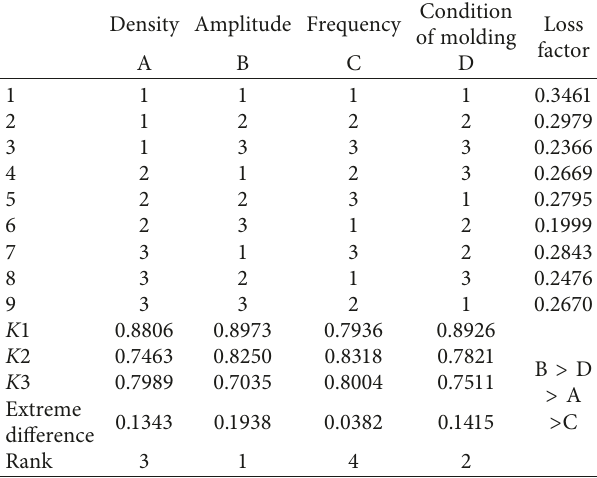
Table 6: Orthogonal test results of the loss factor